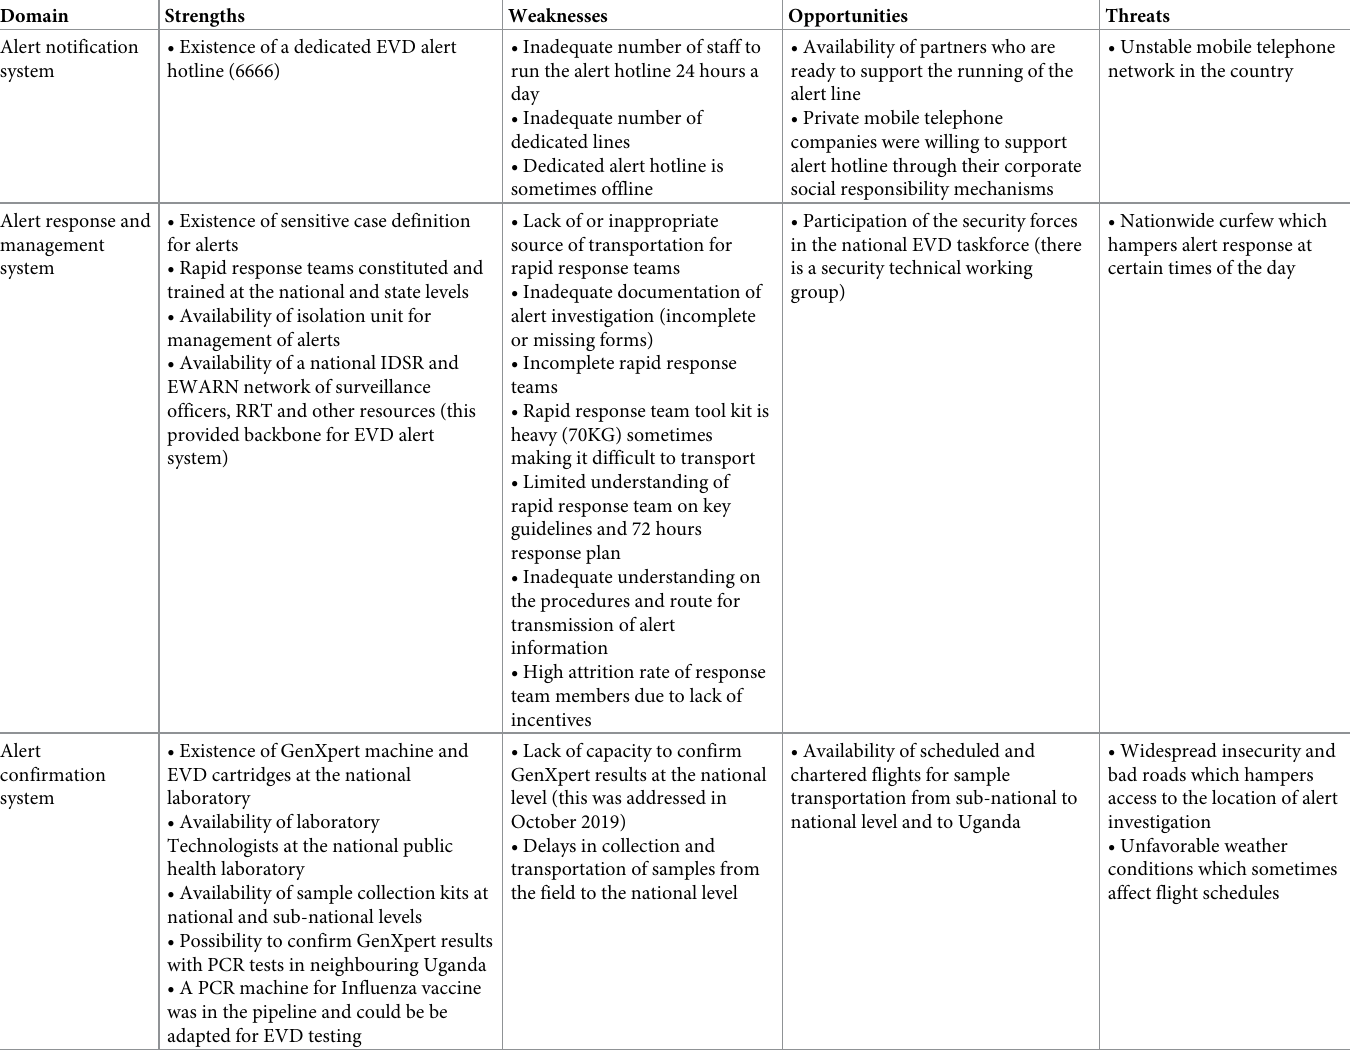
Table 5. Strengths, weaknesses, opportunities and threats to the Ebola virus disease alert management system in South Sudan–August 2018 to October